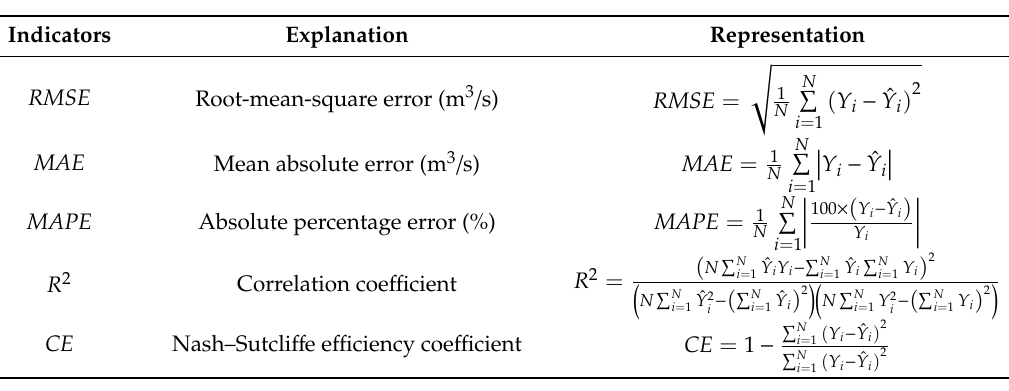
Table 3. Evaluation metrics of the root-mean-square error ( RMSE ), the mean absolute error ( MAE ), the mean absolute percentage error ( MAPE ), and the correlation coe ffi cient ( R 2 ).